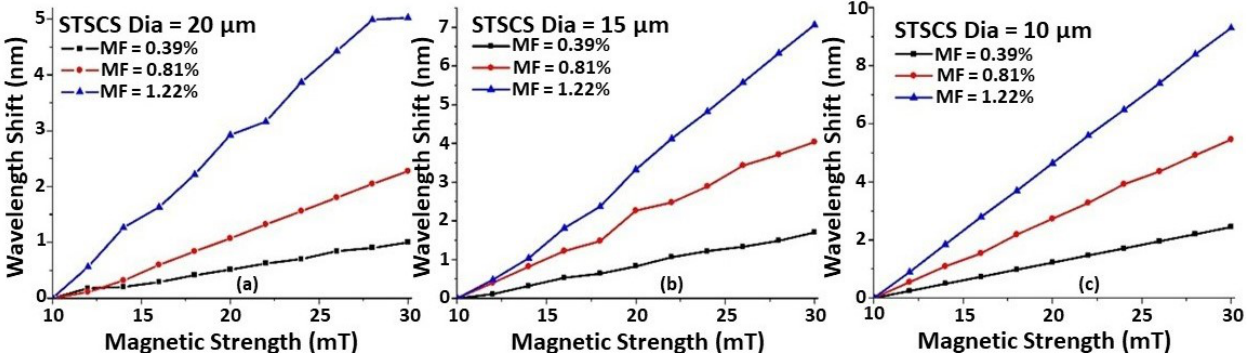
Figure 4. Wavelength shift versus magnetic field strength of STSCS with waist diameters of ( a ) 20 μm, ( b ) 15 μm, and ( c ) 10 μm, surrounded by different MF concentrations (0.39, 0.81, and 1.22% FMPs).